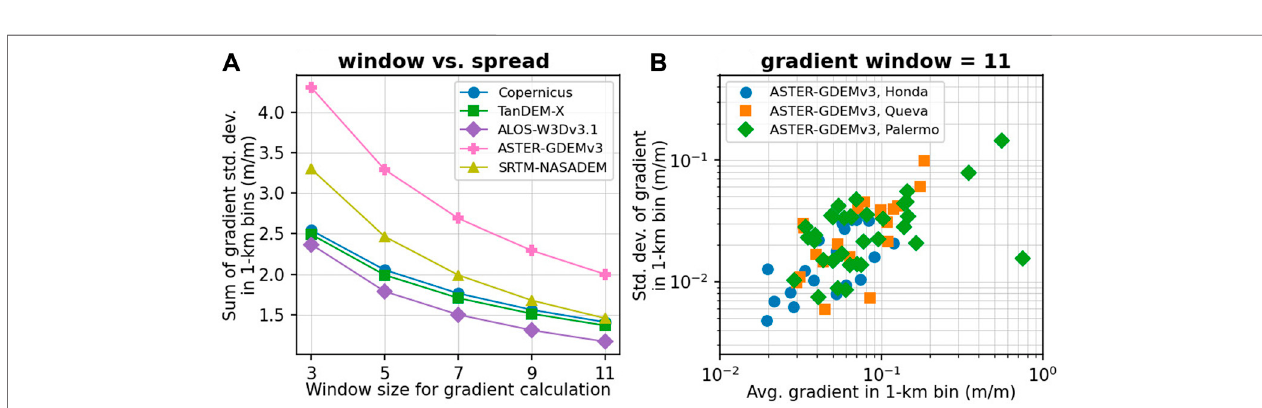
FIGURE 12 | Comparison of trunk stream longitudinal river pro fi le for the Honda Catchment ( Figure 1 ). The left, center, and right columns correspond to the Copernicus,ASTER-GDEMv3,andSRTM-NASADEM,respectively.Thetoprow (A – C) showsthechannelelevationpro fi le (leftaxis) withthechannelnodescoloredby their k sn value, and the channel gradient plotted as black crosses (right axis) calculated from 3-node distances ( ∼ 90 m). The middle row (D – F) shows the standard deviation of the gradient in 1-km fl ow distance bins, where the fi rst row in these sub-plots correspond to the window used in (A – C) . The decrease in gradient standard deviation with increasing window size isshown in (D – F) , with the last row of these sub-plots corresponding tothe last row (G – I) of the fi gure, which shows the resulting gradient calculation using an 11-node ( ∼ 330 m) window. Other DEMs (TanDEM-X and ALOS-W3Dv3.1) and catchments (Queva and Palermo) are shown in Supplementary Figures S7 – S11 .